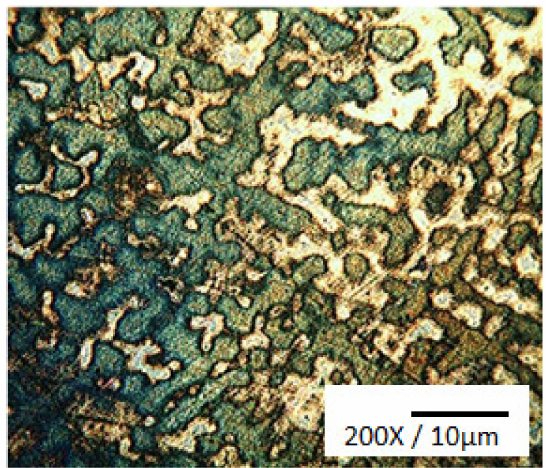
Figure 1. Microstructure of Cu-10Sn alloy in as-cast condition [5].